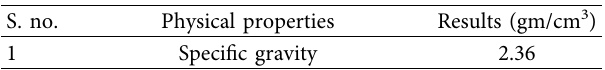
Table 2: Specific gravity of waste paper pulp ash.